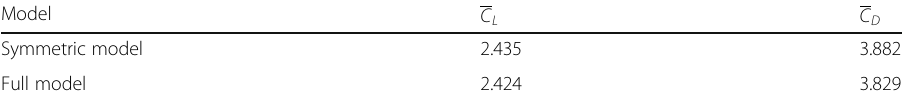
Table 2 Aerodynamic coefficient comparison between symmetric and full model Model